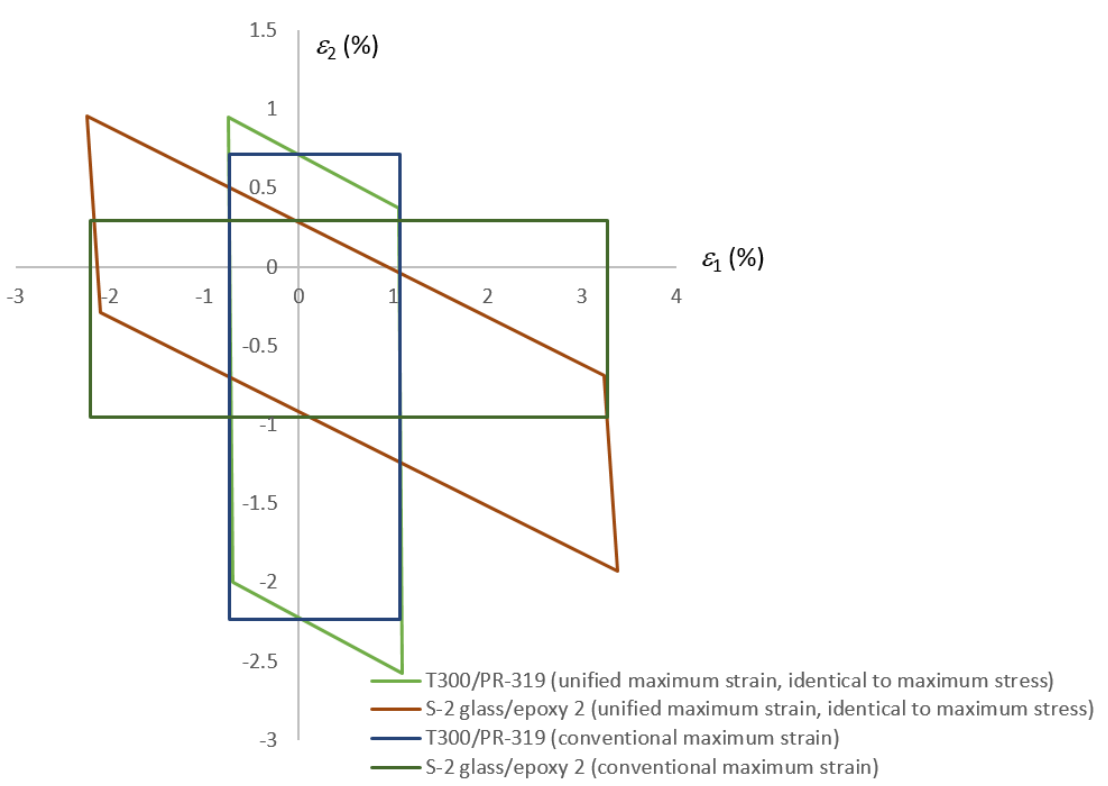
Figure 3. Failure envelopes to scale for two real composites where the conventional and unified maximum strain criteria are compared, with the latter being identical to those from the maximum stress criterion.